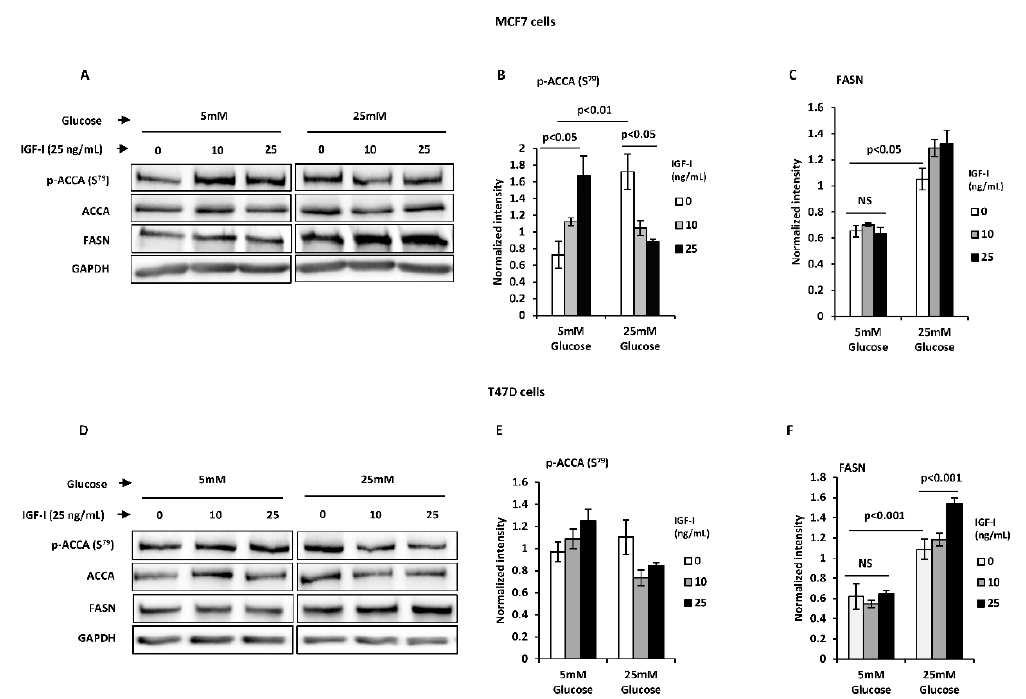
Figure 3. High glucose favours insulin-like growth factor I (IGF-I)-induced lipogenic phenotype in T47D and MCF7 breast cancer cells. Western blot analysis of ( A ) MCF7 and ( D ) T47D cells treated with 0, 10, and 25 ng / mL IGF-I for 24 h under normal and high glucose conditions. Representative blots of each protein from at least three experiments are shown. The graphs show densitometry analyses of phosphorylated acetyl CoA carboxylase (p-ACCA) (S 79 ) normalised to total ACCA and fatty acid synthase (FASN) normalised to glyceraldehyde 3-phosphate dehydrogenase (GAPDH) in ( B , C ) MCF7 cells and ( E , F ) T47D cells. Each bar represents mean ± SEM of three independent experiments. Statistical analyses were performed by one-way ANOVA, followed by Bonferroni’s multiple comparison test.